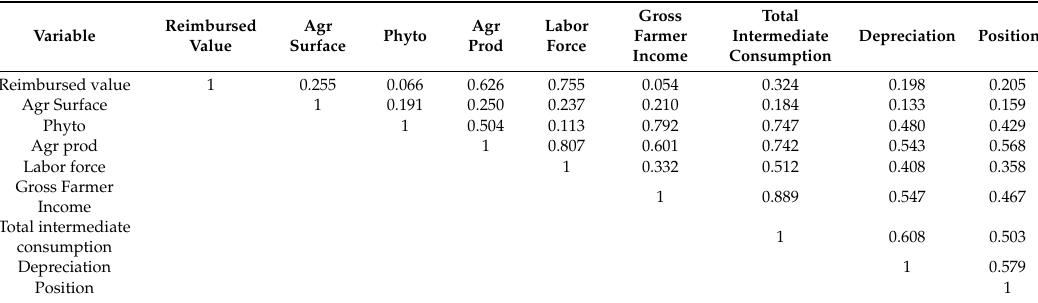
Table 3. Correlation analysis.